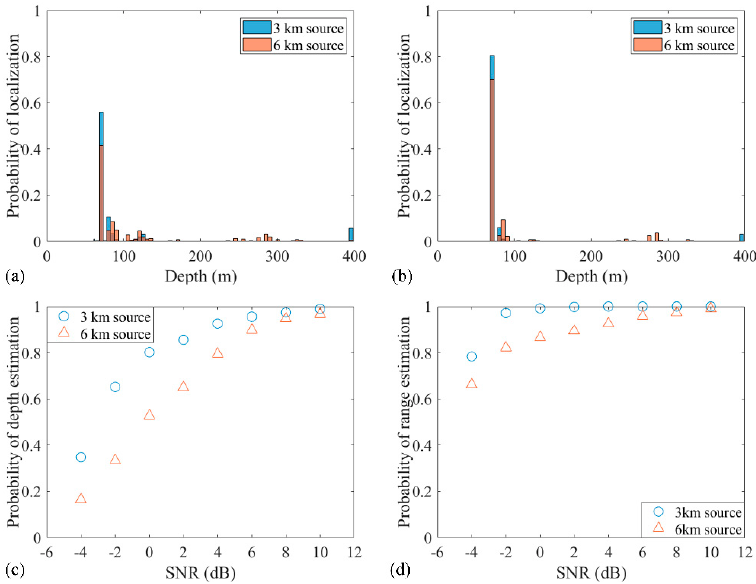
Figure 9. E ff ect of SNRs on the localization for the two-source case with SSR = 5 dB: ( a ) − 2 dB and ( b ) 2 dB. Probabilities of ( c ) depth estimation and ( d ) range estimation with di ff erent